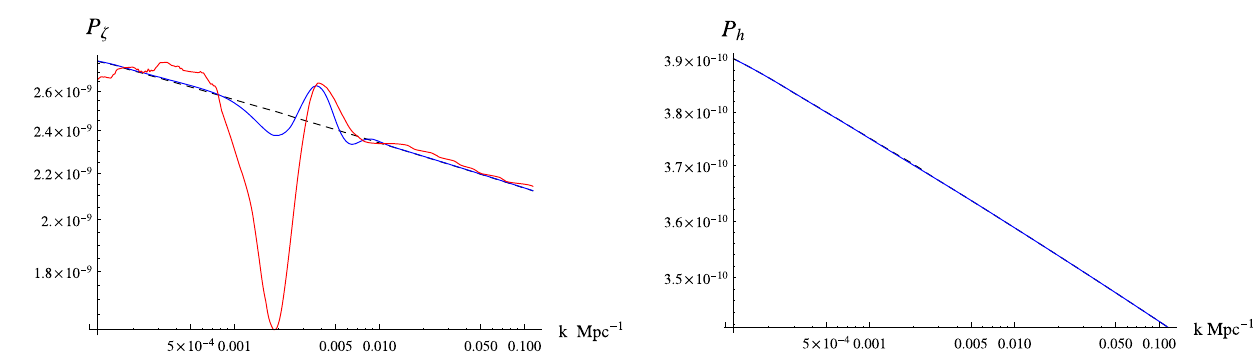
temperature and E-mode polarization modes. We consider the temperature and polarization power spectra in the range 2 ≤ (cid:14) ≤ 29 (low- (cid:14) ) and only the temperature power spec- trum at higher multipoles, 30 ≤ (cid:14) ≤ 2500 (high- (cid:14) ).